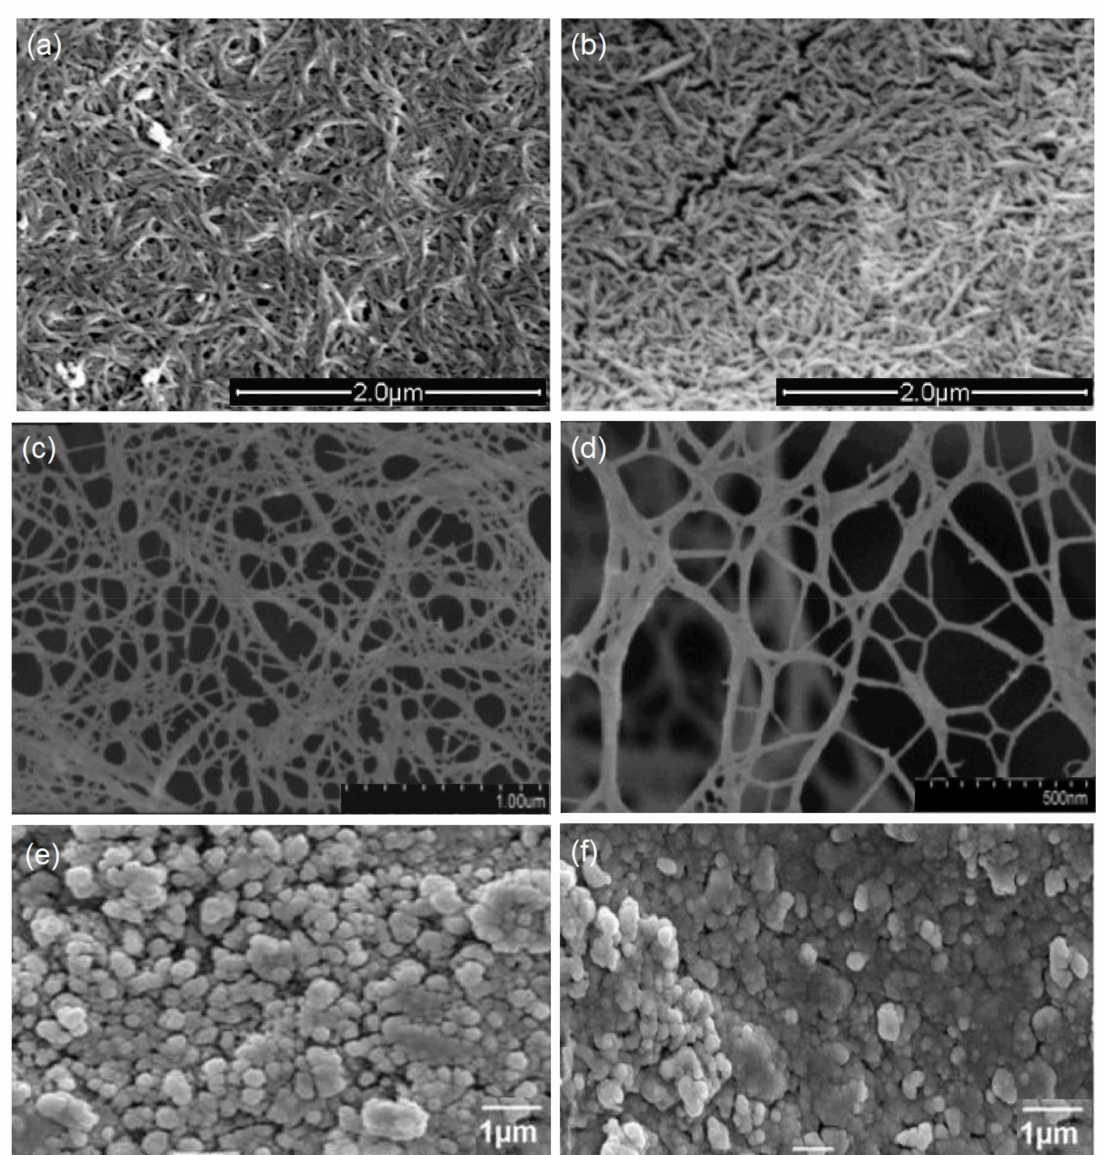
Figure 4. Scanning electron microscope (SEM) images of di ff erent forms of nanocellulose materials. ( a , b